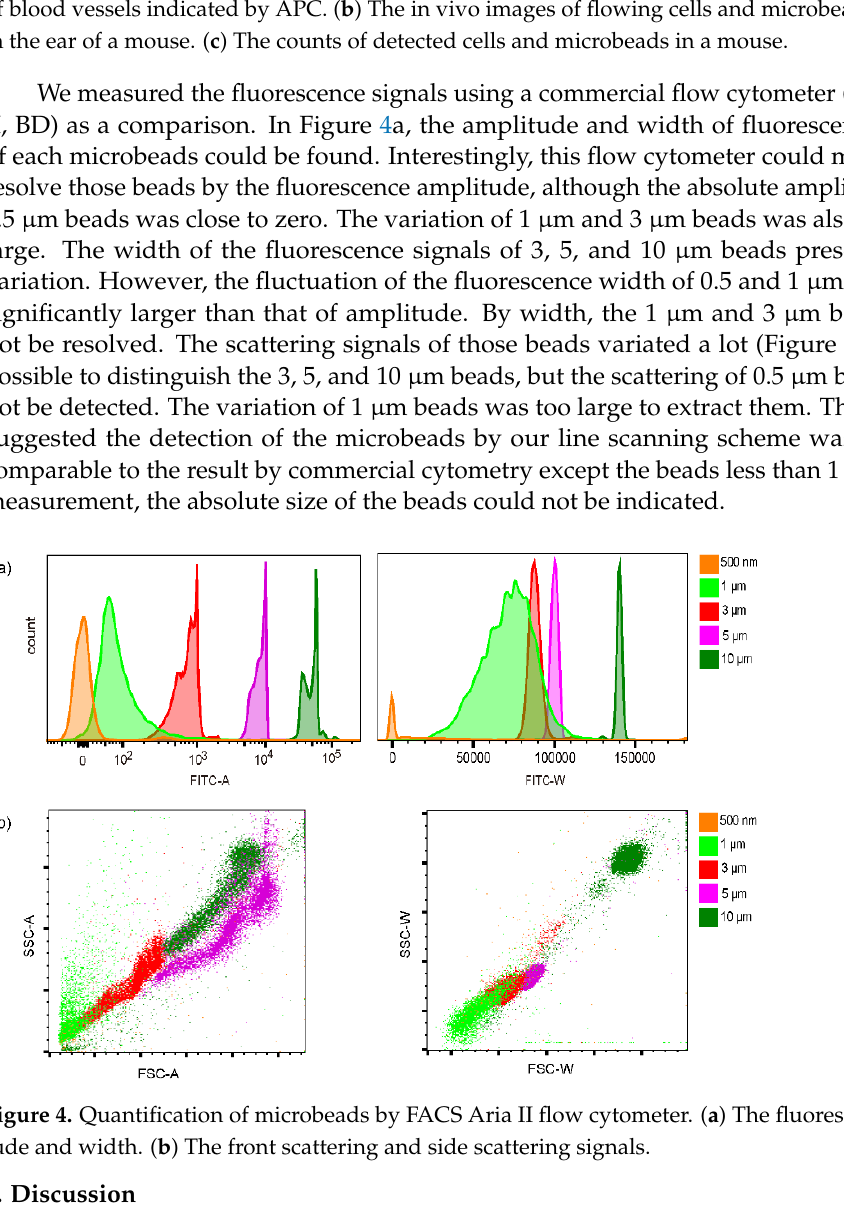
Figure 4. Quanti fi cation of microbeads by FACS Aria II fl ow cytometer. ( a ) The fl uorescence ampli- tude and width. ( b ) The front sca tt ering and side sca tt ering signals. 4. Discussion In this study, we present a simple scheme to construct an in vitro and in vivo cytom- etry by continuous temporal line scanning of confocal microscope systems without any modi fi cation. The laser was focused to a submicron di ff raction limit in this method. Hence this scheme can theoretically resolve particles larger than 1 µm and provide direct meas- urement, not only distinguish them. The fast line scanning of excitation lasers in confocal microscopes can work as a dynamic light sheet to excite passing samples. According to the laser scanning speed along a 100 µm line that is around at the millisecond level for a